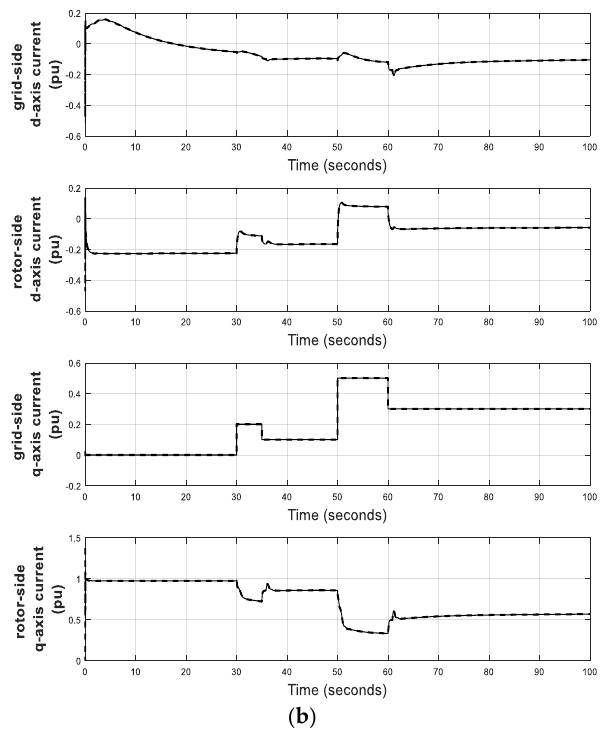
Figure 12. The droop-fed vector control based VSPS system without wind farm: ( a ) tracking of power instructions on outer loop control; ( b ) tracking of inner loop control reference signals.